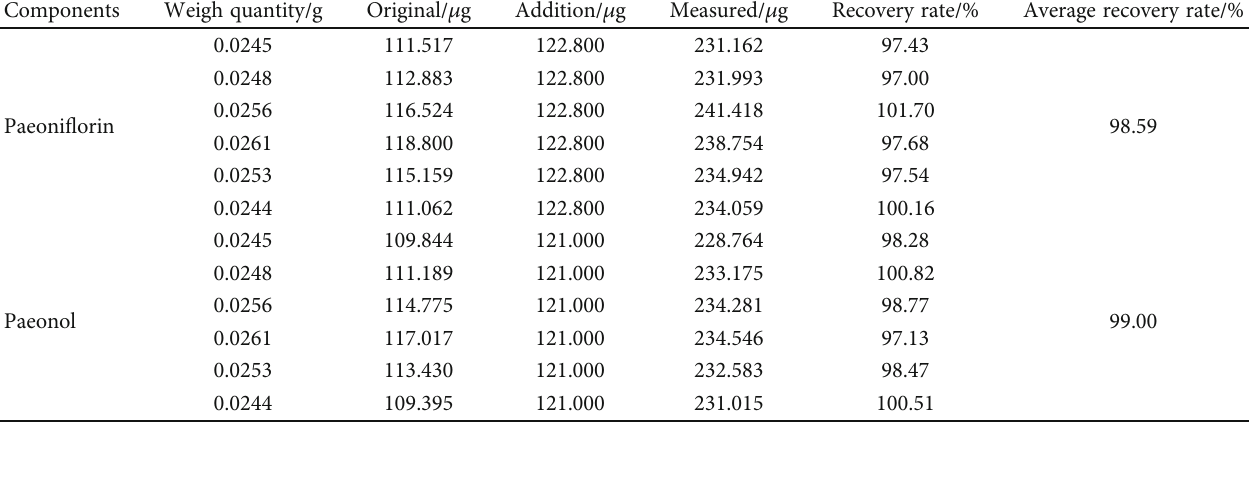
Table 3: Precision and method accuracy.